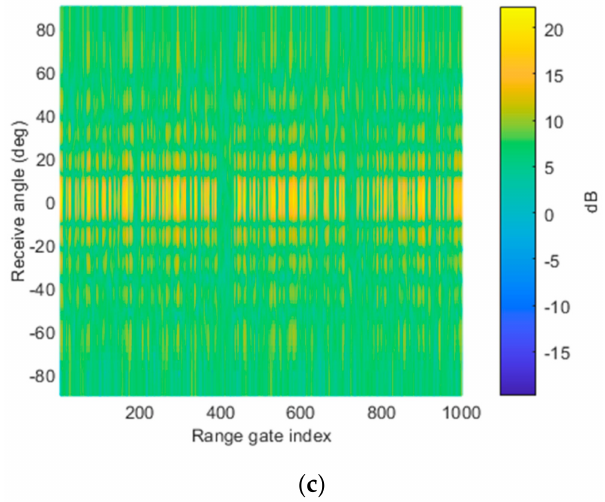
Figure 4. Fourier power spectrum of the receive signal, including the true target and RGPO false targets in the ( a ) normalized Doppler frequency and range dimensions; ( b ) transmit spatial angle and range dimensions; and ( c ) receive spatial angle and range dimensions.